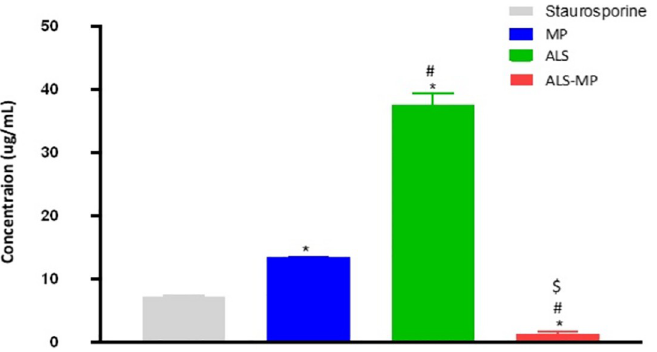
Fig 4. Comparative cytotoxicity of various samples in terms of IC50. � Significantly different from Staurosporine p < 0.05, #significantly different from MP p < 0.05, $signifi-cantly different from ALS p <